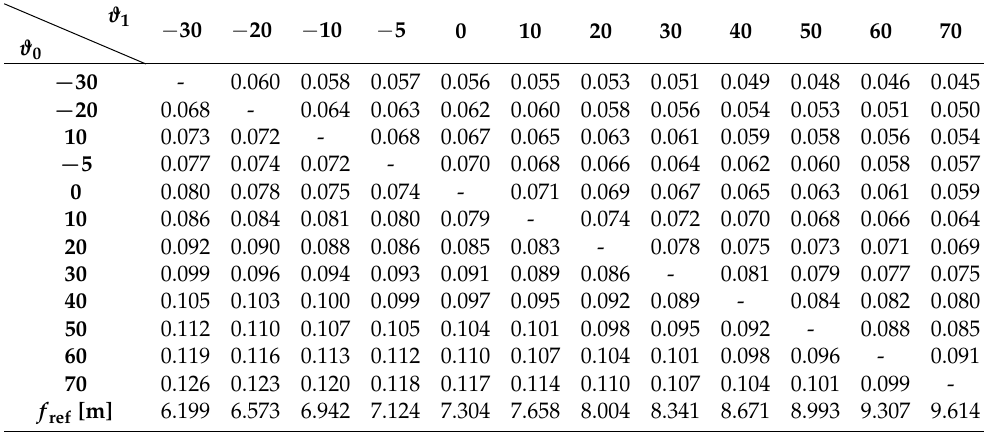
Table 7. Maximum absolute sag deviations ∆ f γ [m] caused by the incorrect determination of the conductor specific gravity load by ±